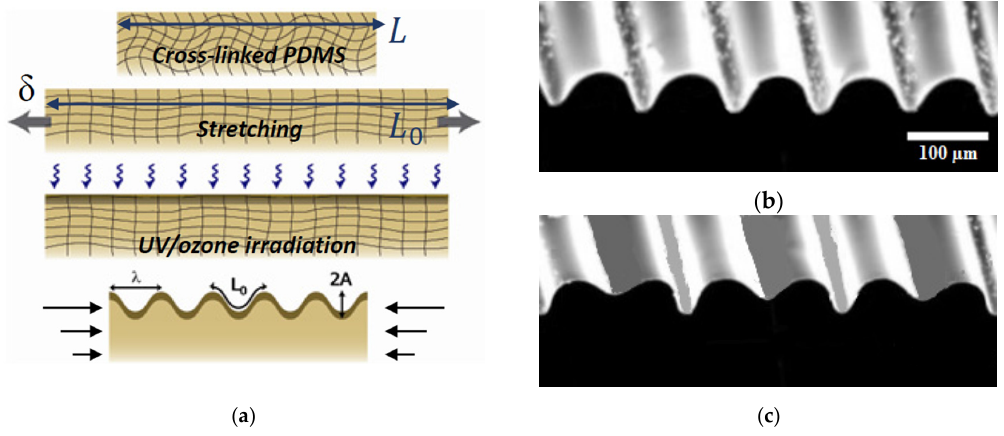
Figure 1. ( a ) Schematics illustrating the steps for fabricating micro-wrinkling pattern on the poly-dimethylsiloxane (PDMS) substrate; ( b , c ) Scanning Electron Microscope (SEM) images of wrinkling pattern on a thin stiff PDMS film resting on a thick soft PDMS foundation and obtained with mechanical compression of 28% and 38% respectively.